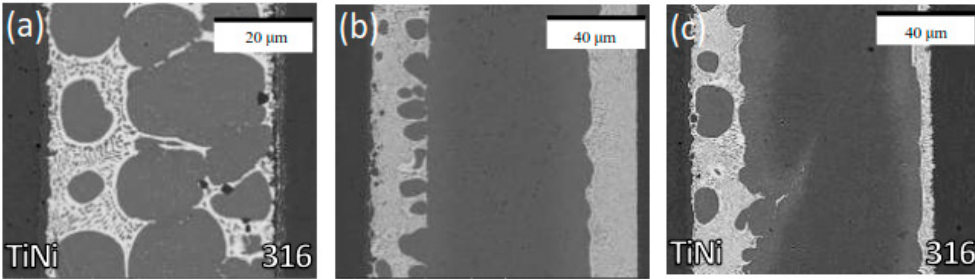
Figure 4. SEM BEI cross sections of Ti 50 Ni 50 /Cusil-ABA/Cu/BAg-8/316L SS specimens infrared brazed at 850 °C for 300 s with the Cu interlayer of ( a ) 25 μ m; ( b ) 50 μ m; ( c ) 70 μ m. (TiNi: Ti 50 Ni 50 substrate, 316: 316L SS substrate).